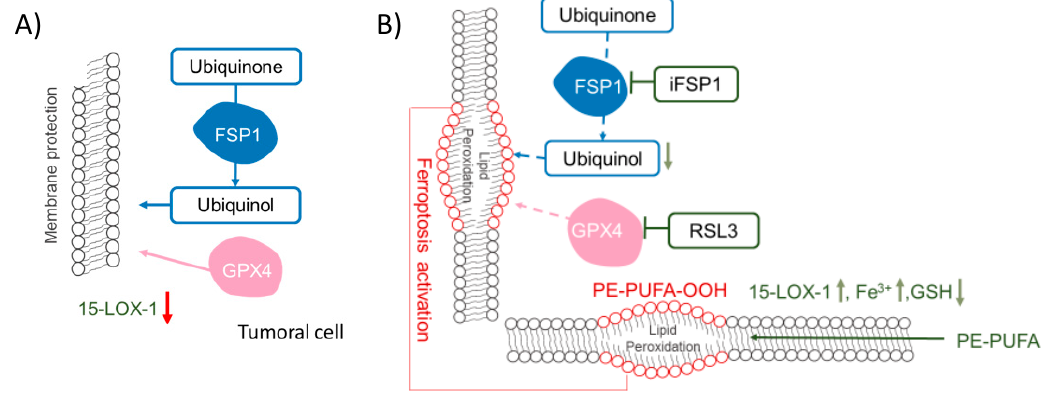
Figure 2. Glutathione peroxidase 4 (GPX4) and ferroptosis suppressor protein 1 (FSP1) function in cancer cells. Role of ubiquinone reduction through FSP1 and GPX4 in the protection of the membrane against lipid peroxidation in cancer cells ( A ). In cancer cells, the antioxidant enzymes GPX4 and FSP1, which act on reducing lipid hydroperoxides, would protect them against cell death. Lipid peroxidation and stimulation and ferroptosis induction by the FSP1 and GPX4 inhibitors’ such as iFSP1 and RSL3, respectively ( B ). By the blockage of these enzymes and stimulation of LOXs, such as 15-LOX-1, lipid peroxidation is prompted. Moreover, substrates of these enzymes and mediators such as GSH and iron could stimulate ferroptosis in cancer cells.